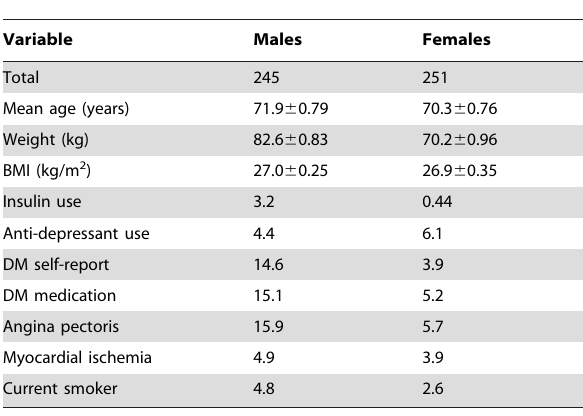
Table 1. Descriptive characteristics of study